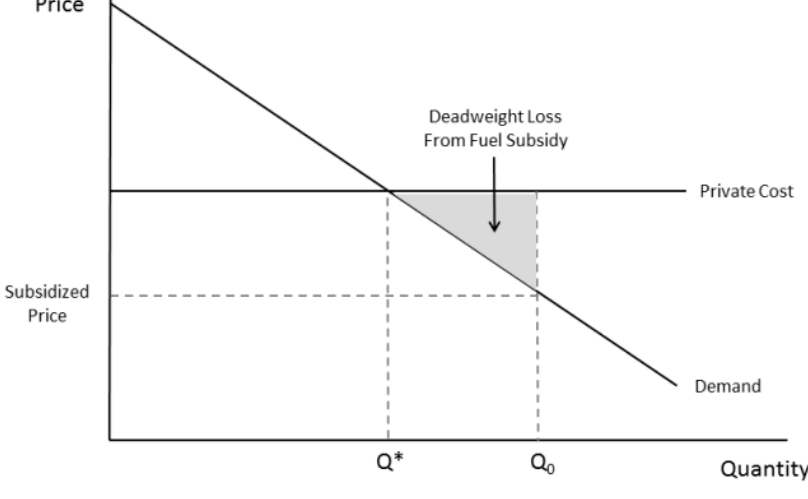
Figure 3. Diesel subsidies in Indonesia.